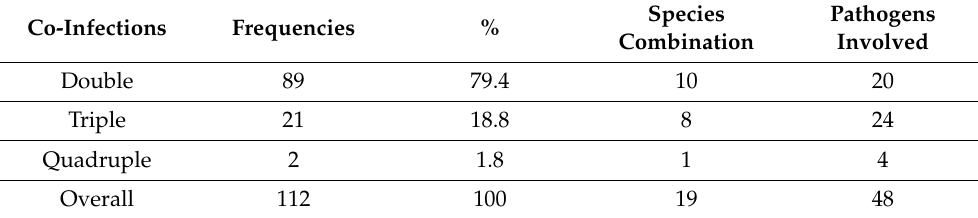
Table 5. Observed co-infection, frequencies, number of species combination and pathogens